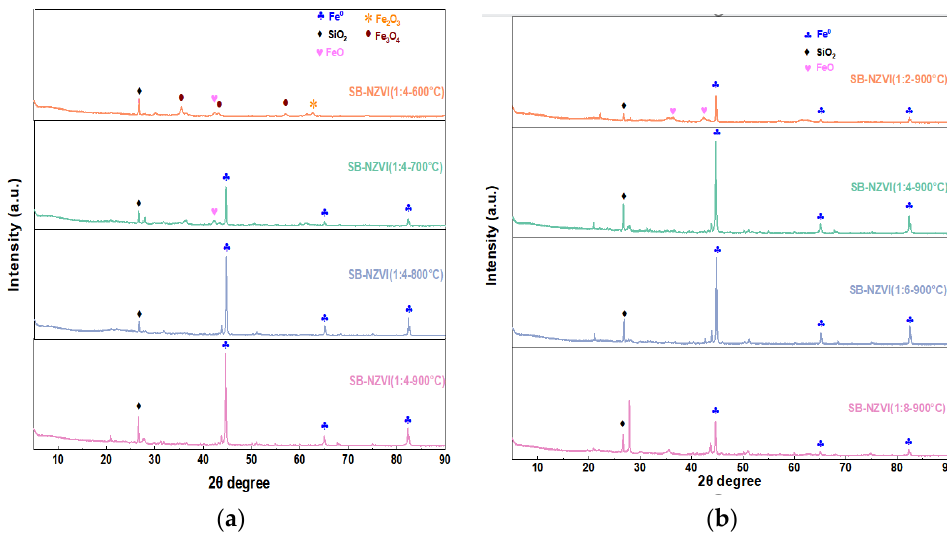
Figure 1. XRD patterns of ( a ) SB-NZVI at different temperatures and ( b ) with different mass ratios of Fe to sludge.